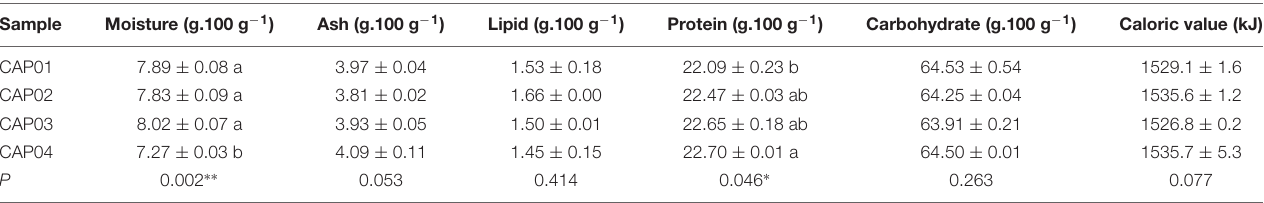
TABLE 4 | Nutritional compositions of four Caparrona de Monzón bean accessions (CAP01, CAP02, CAP03, and CAP04) grown in Monzón